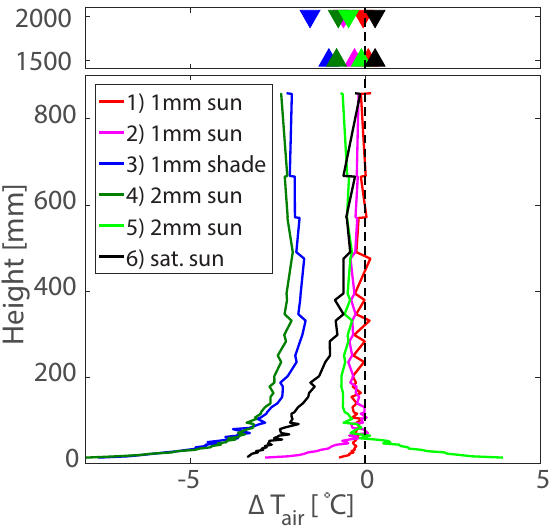
Figure 5. Temperature differences for average value of each layer before and after the uchimizu treatment ( T after – T before ). The chosen times are different for each experiment and represent the maximum temperature drop, i.e., the difference between the maximum temperature before the uchimizu and the minimum temperature after: For (E1) T t + 6 –T t + 1 , (E2) T t + 3 –T t − 2 , (E3) T t + 6 –T t − 2 , (E4) T t + 8 –T t − 2 , (E5) T t + 2 –T t − 2 , (E6) T t + 7 -T t − 3 , where t represents the time of uchimizu in minutes. The triangles on